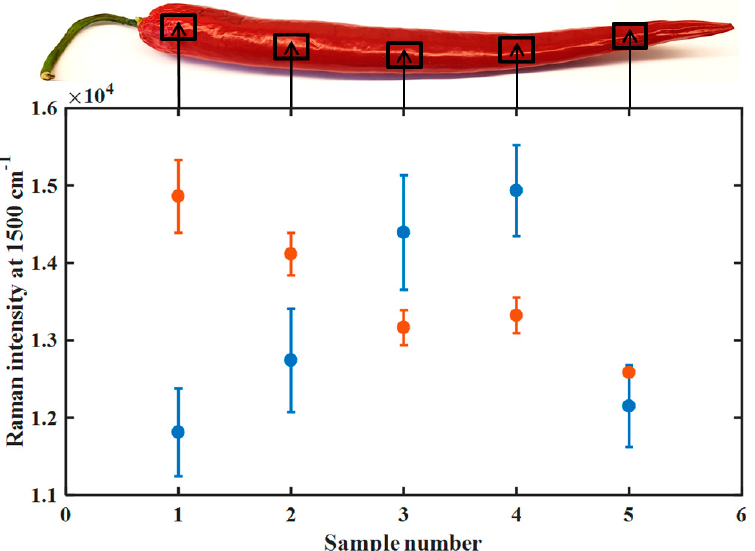
Figure 4. Raman band intensities at 1500 cm − 1 and their variation as measured at five spots of a single fully ripe pepper, cf. top picture and marked positions, using the mobile (blue) and benchtop (orange) Raman spectrometers.